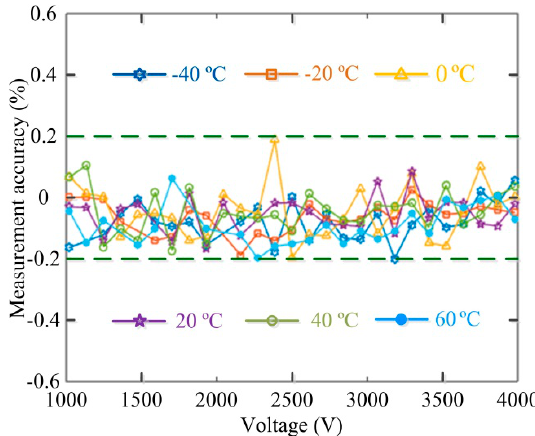
Figure 11. Relative measurement errors of OVS at different temperatures.